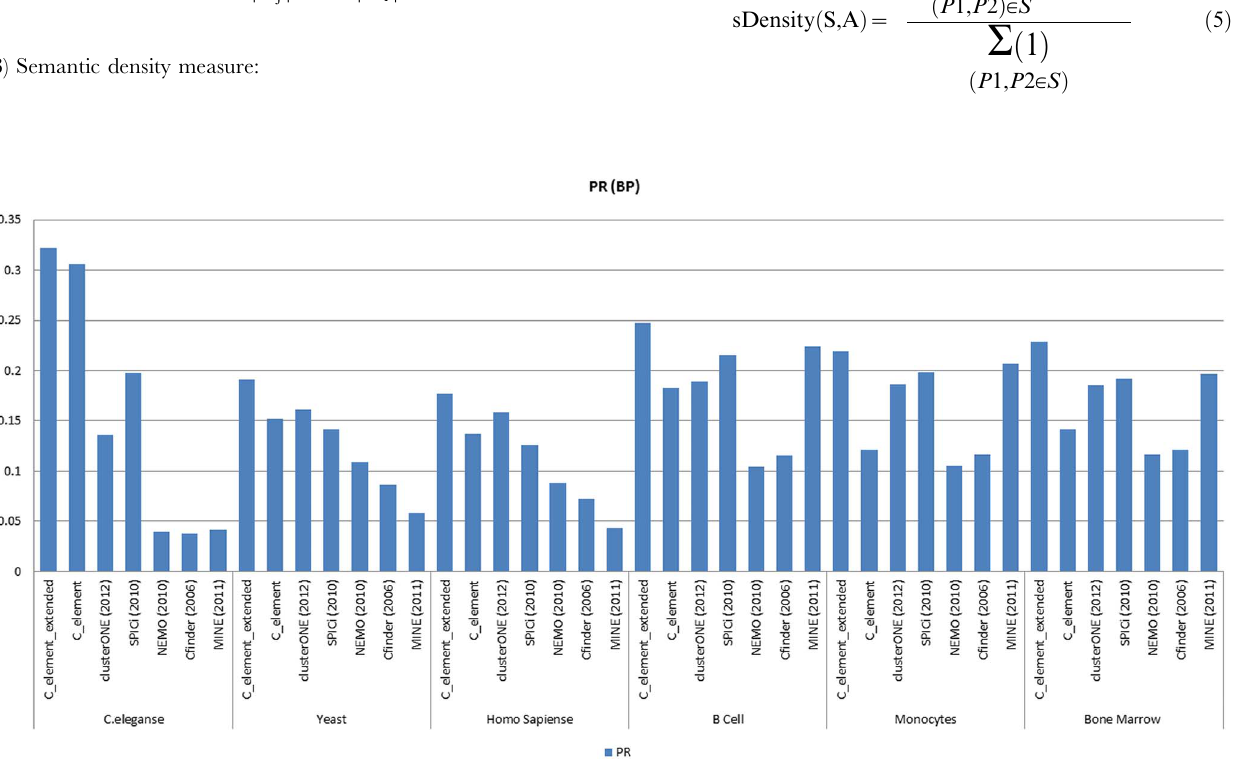
Figure 8. Jaccard measure analyses results on the different network datasets and different algorithms when GO BP derived functional modules were considered.